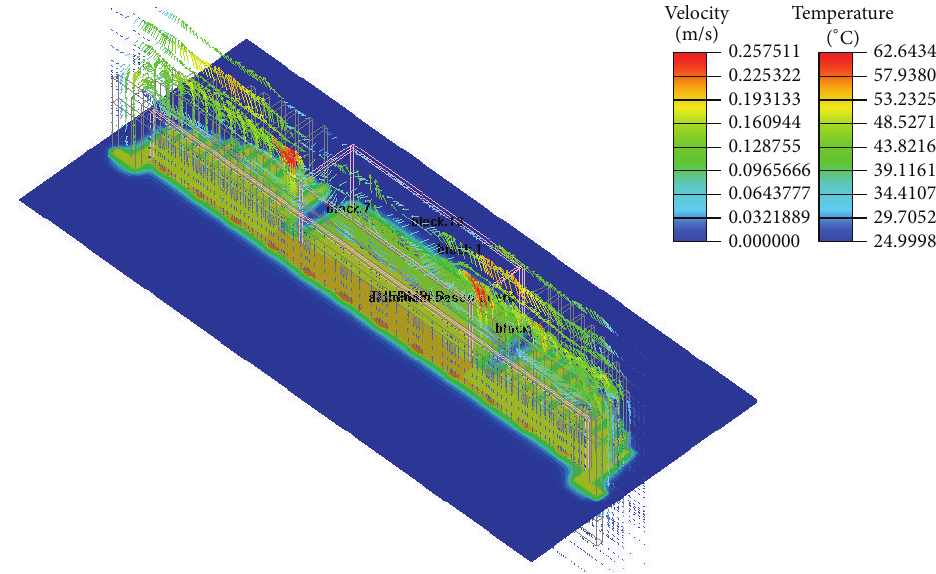
Figure 7: Icepak simulation results.